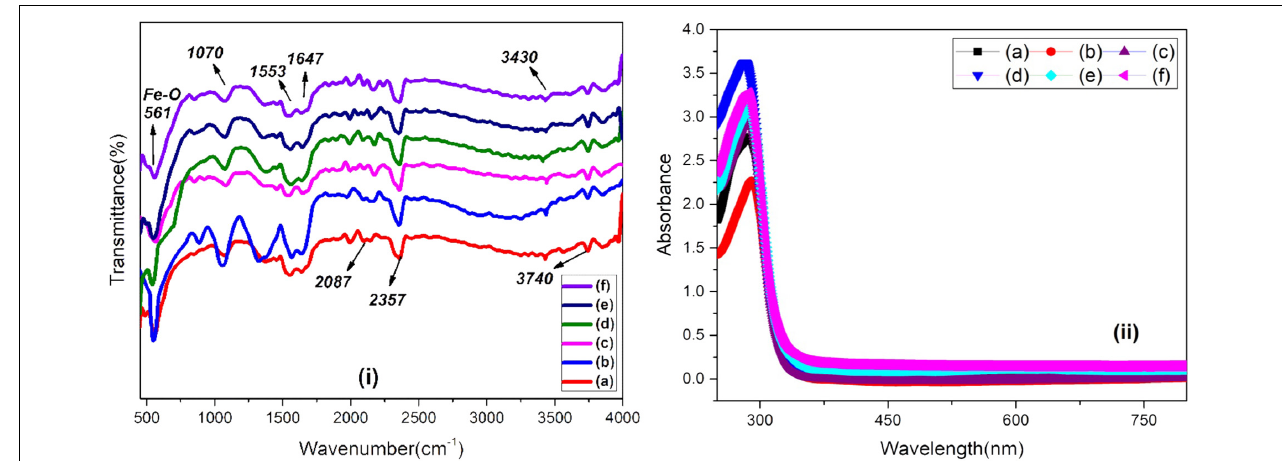
FIGURE 6 | (i) FTIR and (ii) UV-visible spectra of green-synthesized IONPs by using (A) PJ, (B) WV, (C) PP, (D) BC, (E) AP, and (F) As extracts.